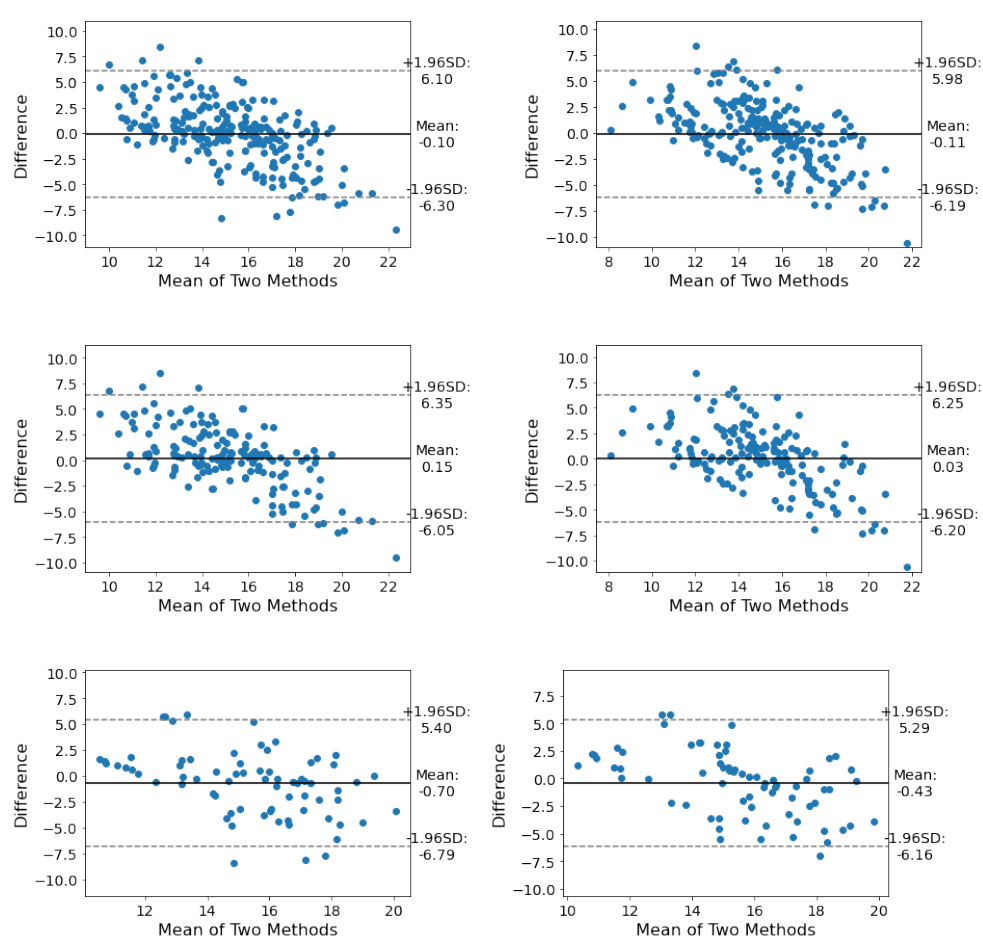
Figure 5. The LoA between the respiratory estimation of Se 1 ( left ) and Se 2 ( right ) under the thoracic and abdominal regions. From top to bottom: LoA of all subjects, males, and females. In total Se 2 showed a better agreement with the reference